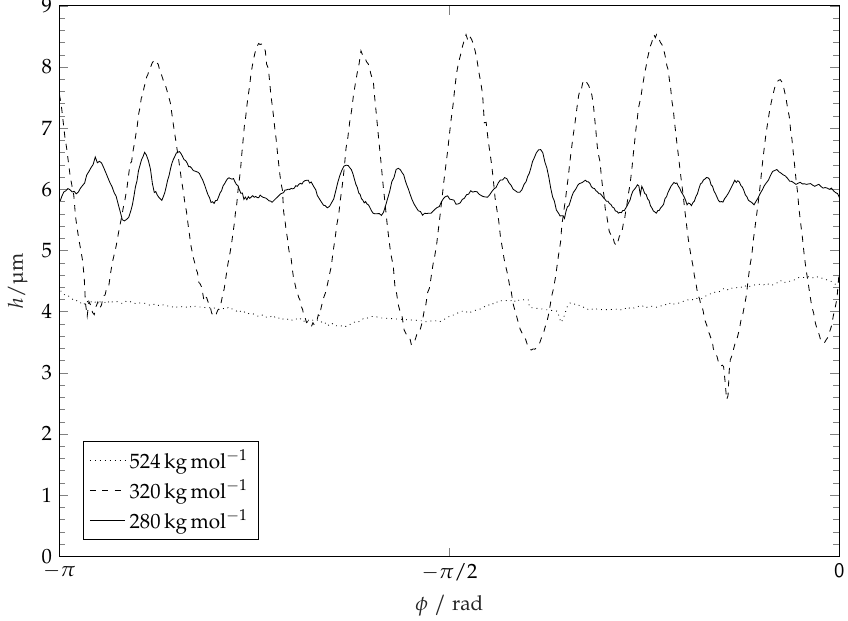
Figure 12. Ridge heights over angular coordinate show pertubations along ridge line. Graphs show heights above original coating level. Coating molar mass shows influence on pertubation frequency and amplitude. For a better visualisation, only half cycles are